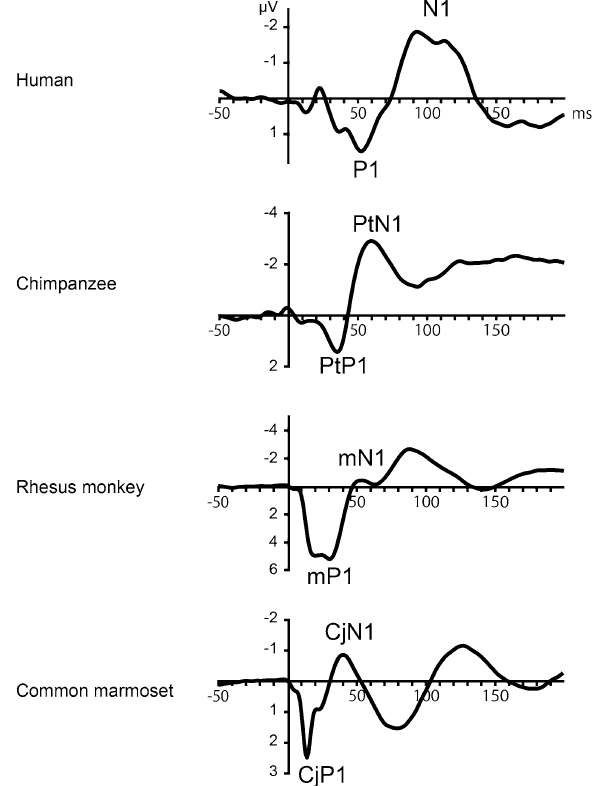
Figure 1. Scalp-recorded CAEPs in the four primate species investigated in the study. The homologs of human P1/N1 were identified as PtP1/PtN1 in the chimpanzee, mP1/mN1 in the rhesus monkey, and CjP1/CjN1 in the common marmoset. The latencies of P1/N1 homologs are elongated as the brain size increases. The electrode was placed at the vertex. CAEP cortical auditory-evoked potential.